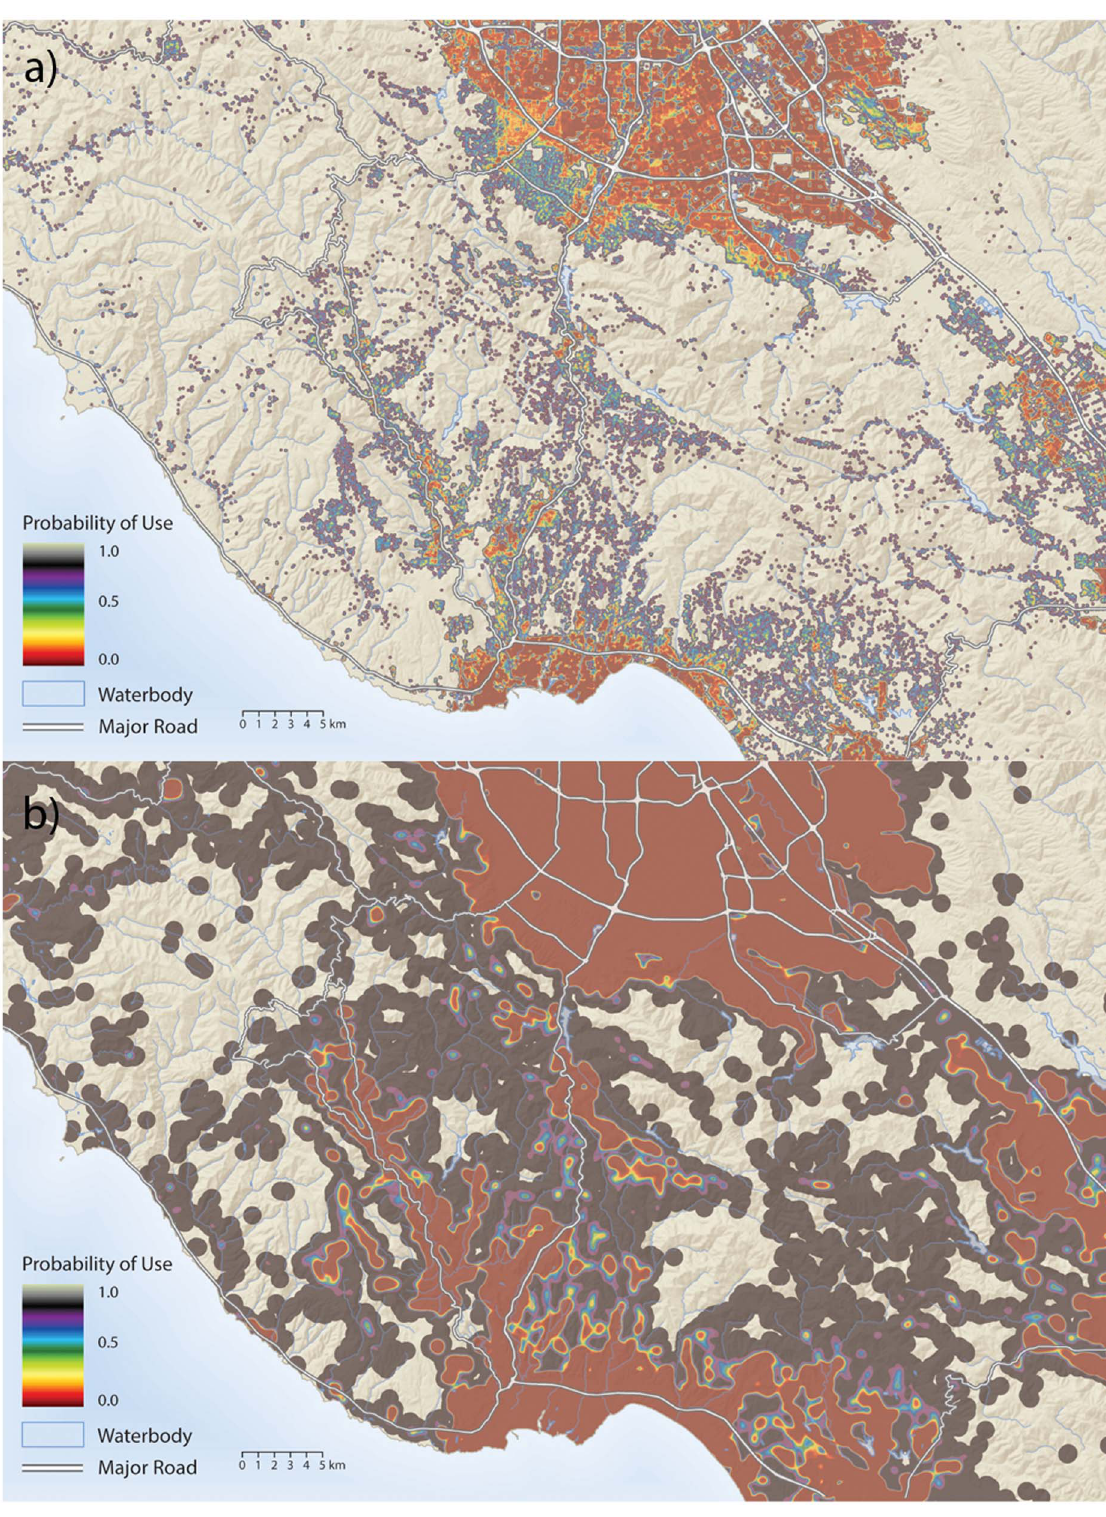
Figure 4. Maps of the study area displaying the relative probability of use by pumas in relation to housing density when they are either a) feeding, or b) communicating. Intermediate colors on the feeding map are areas that pumas are likely to avoid, but will still visit occasionally to hunt and feed. It is here that most puma mortality occurs over conflicts with livestock owners. The light colored areas on the communication map represent areas where pumas are not impacted by housing density when communicating (or denning). These areas would make good candidates for reserves.